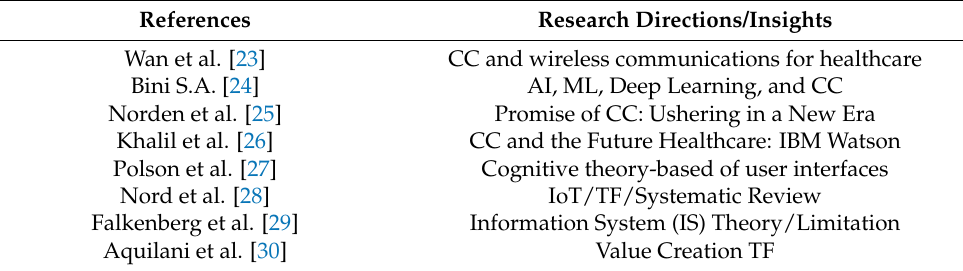
Table 2. CC, AI, and ML theoretical framework (TF)